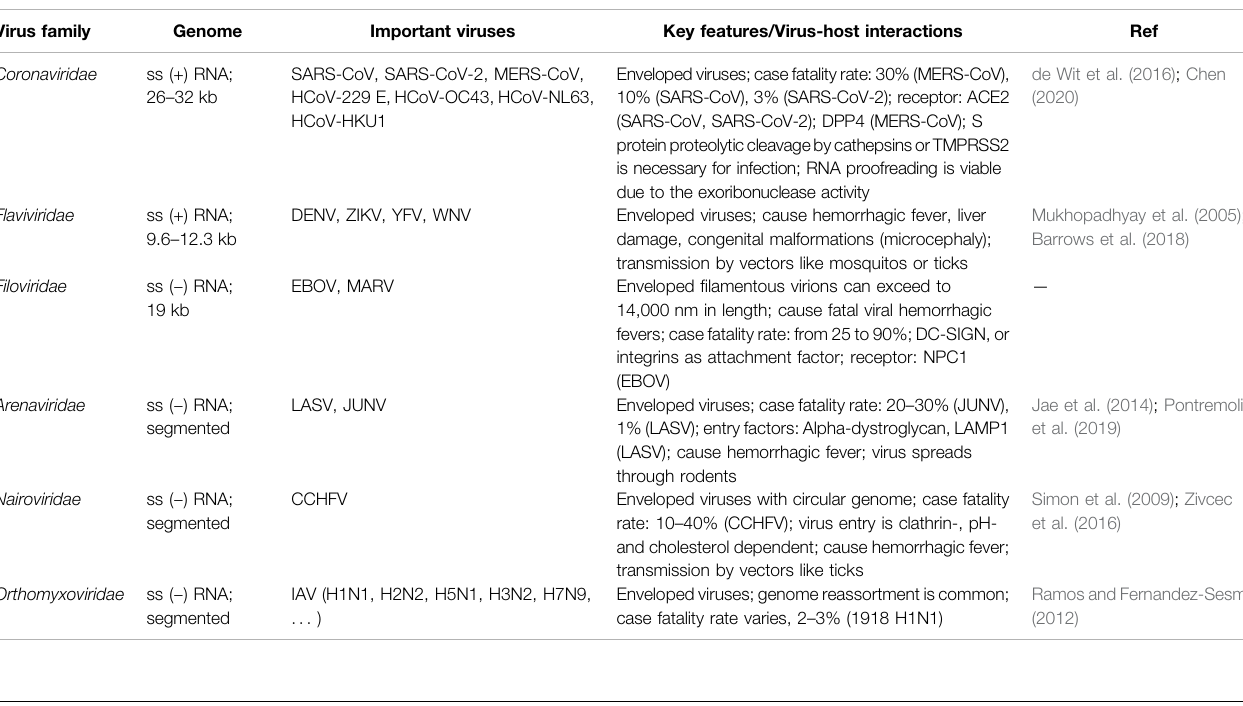
TABLE 1 | Important emerging or remerging viruses. Virus family Genome Important viruses Key features/Virus-host interactions